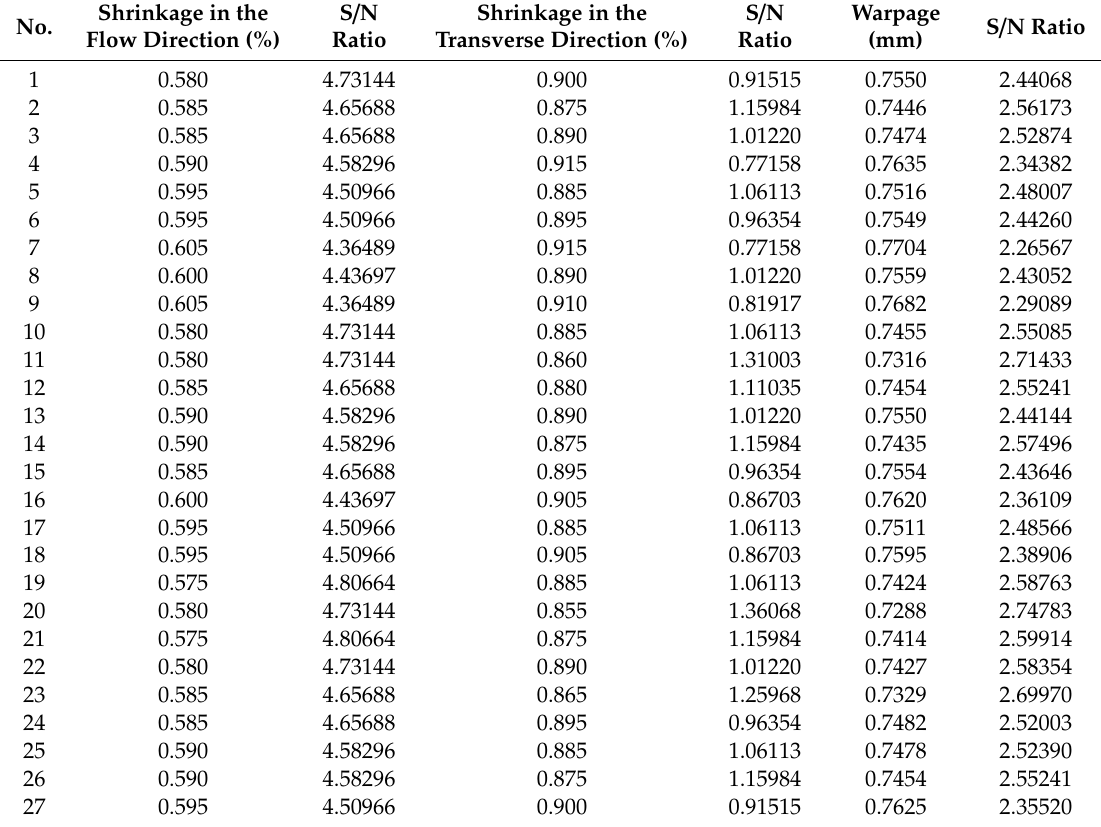
Table 4. Experimental results and S / N